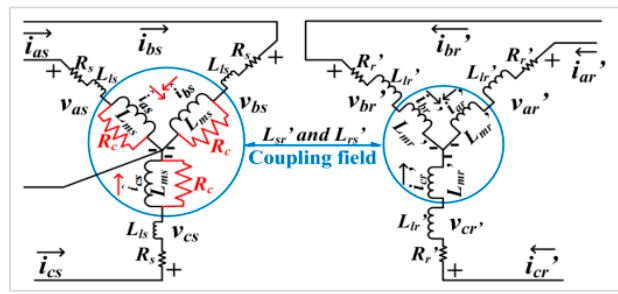
Figure 4. Loss model of an induction motor [27].